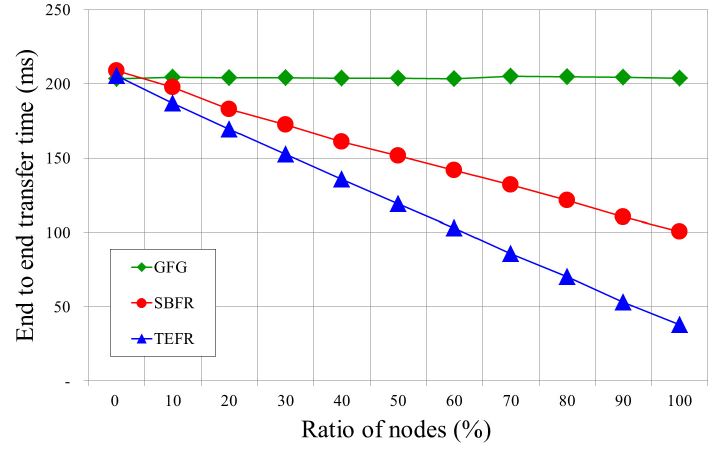
Figure 12. Transfer time according to ratio of nodes capable of direct transmission (radio range: 100 m, deployed nodes: